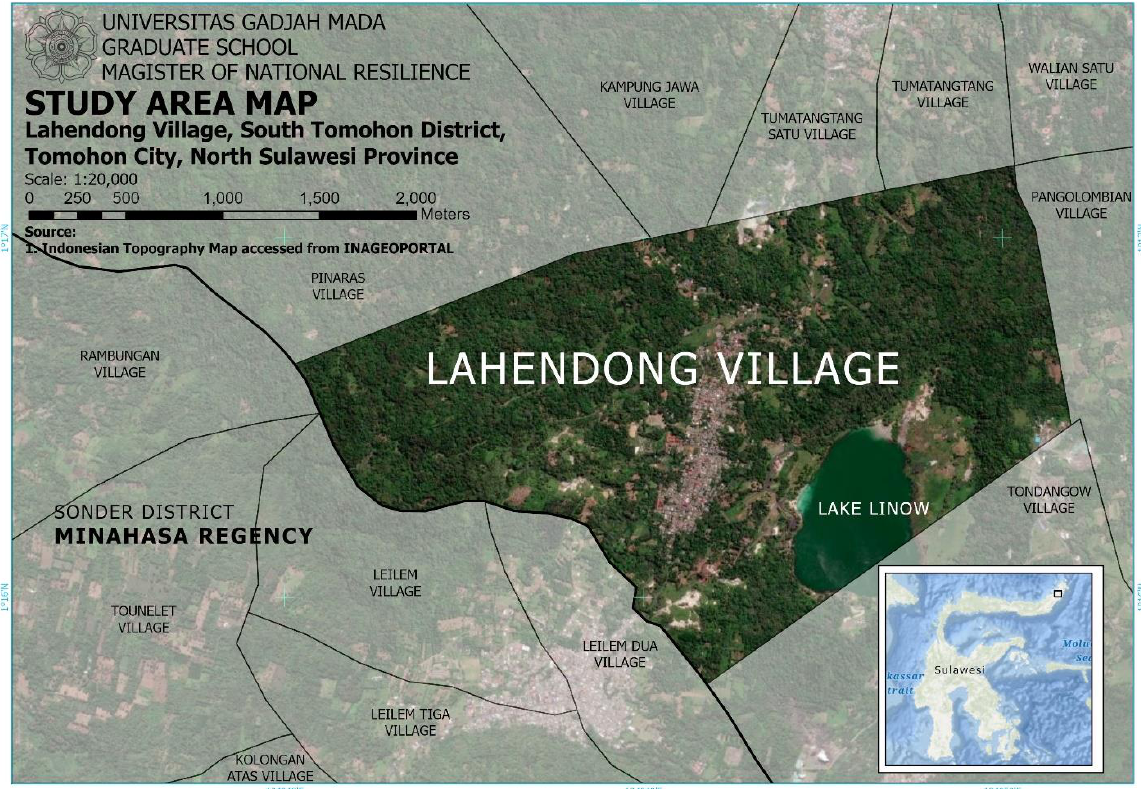
Fig 1 . Study Area Map: Lahendong Village in South Tomohon District, Tomohon City, North Sulawesi Province “ Arisan Rukun” is a part of social gathering activities in Lahendong. The social gathering activity, is an activity that is participated usually in by a group of women in the Lahendong sub-district. “ Arisan Tanggal” is held every day for one month, according to the date followed. The amount of dues is determined by each group. As for one person can take part in more than Arisan Tanggal group in Lahendong sub-district. The purpose of holding a social gathering is as a place to socialize between neighbors, as well as to save money without burdening the family's